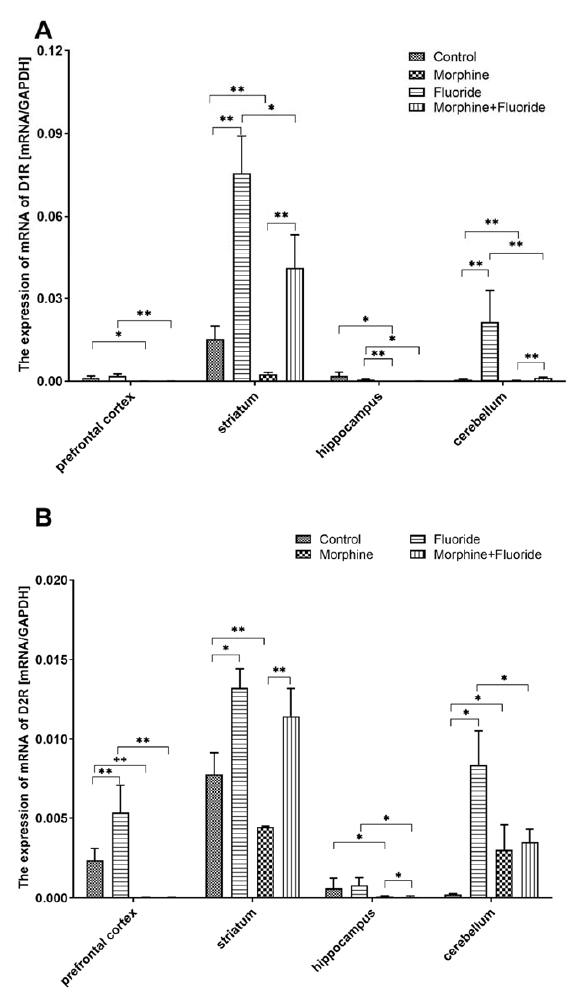
Figure 3. The expression of mRNA of D1R ( A ) and D2R ( B ) in the prefrontal cortex, striatum, hippocampus, and cerebellum of the rat brain in the control, fluoride, morphine, and morphine + fluoride groups. Rats were treated with 50 ppm of NaF and / or were administered morphine in increasing doses (10–50 mg/kg). The results are presented as means ± SD. The statistical analysis was performed using the Mann–Whitney U test * p < 0.05, ** p < 0.01.